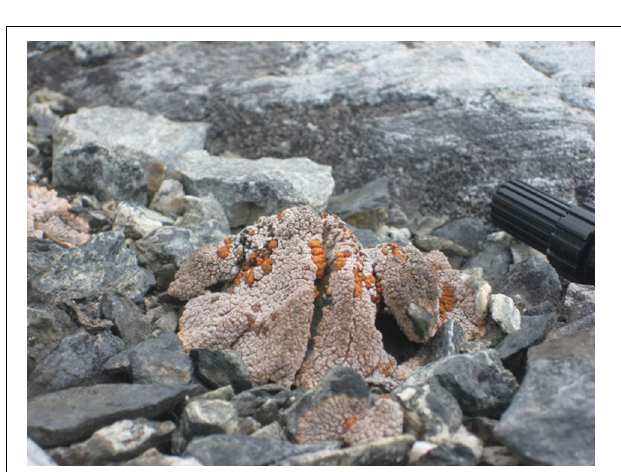
FIGURE 6 | High altitude thermally heated soils near the summit of Mt Erebus.